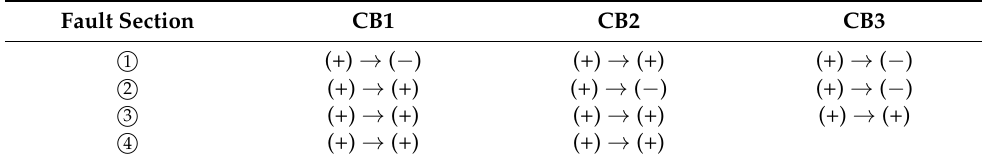
Table 1. Change of current polarity in CB1, CB2, and CB3 at each fault section. Fault Section